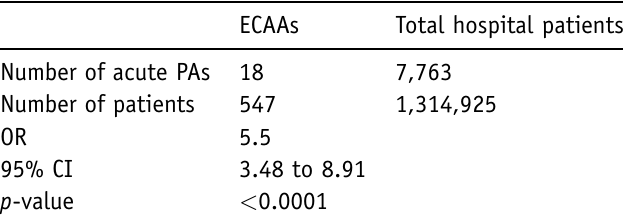
Table II. Prevalence of acute periapical abscesses (PAs) in extracranial carotid artery aneurysms (ECAAs) patients. OR = odds ratio; CI = con fi dential